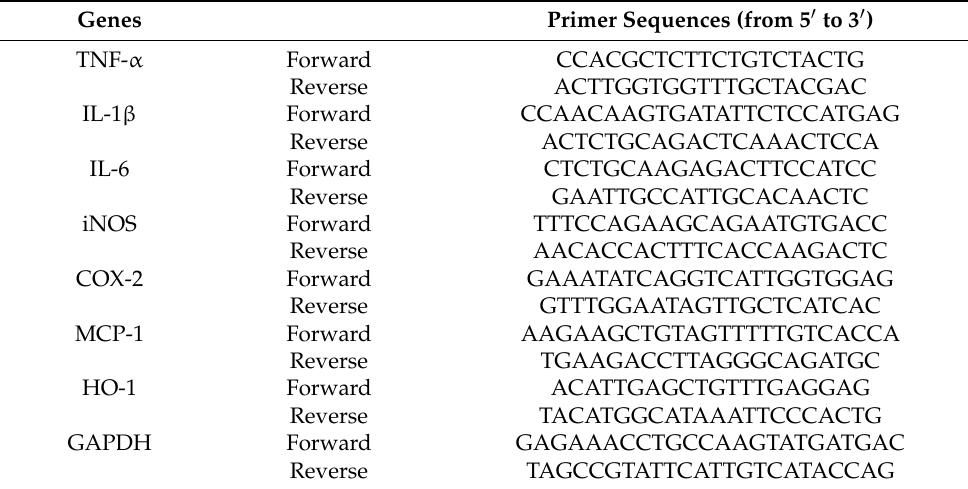
Table 4. Primer sequences used in RT-qPCR. Genes Primer Sequences (from 5 (cid:48) to 3 (cid:48)